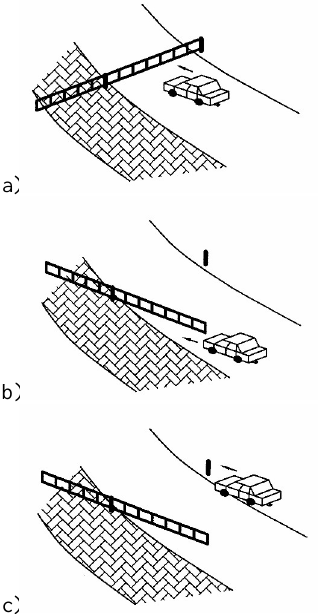
Fig 3. The scheme of motor vehicle–gate interactions